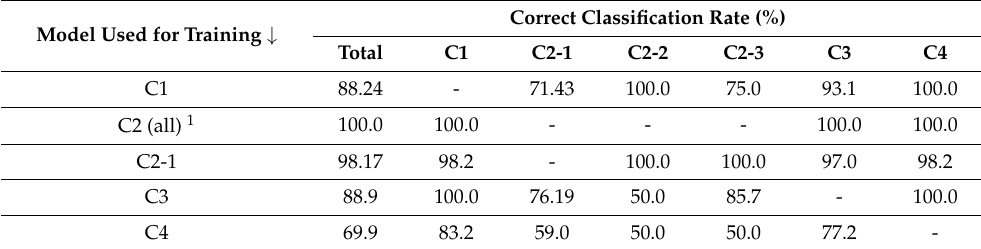
Table 1. Correct classification rate for all types of food-grade tissue using models created at individual sites. Model Used for Training